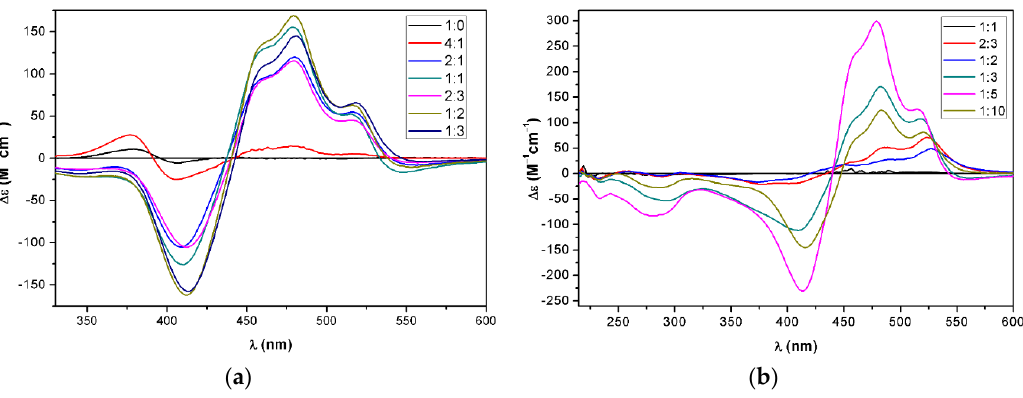
Figure 4. ( a ) The ECD spectra of bistriazole daidzein-zeaxanthin conjugate 17 in acetone/water mixtures 1:0–1:3 ( b ) in THF/water mixtures 1:1–1:10.